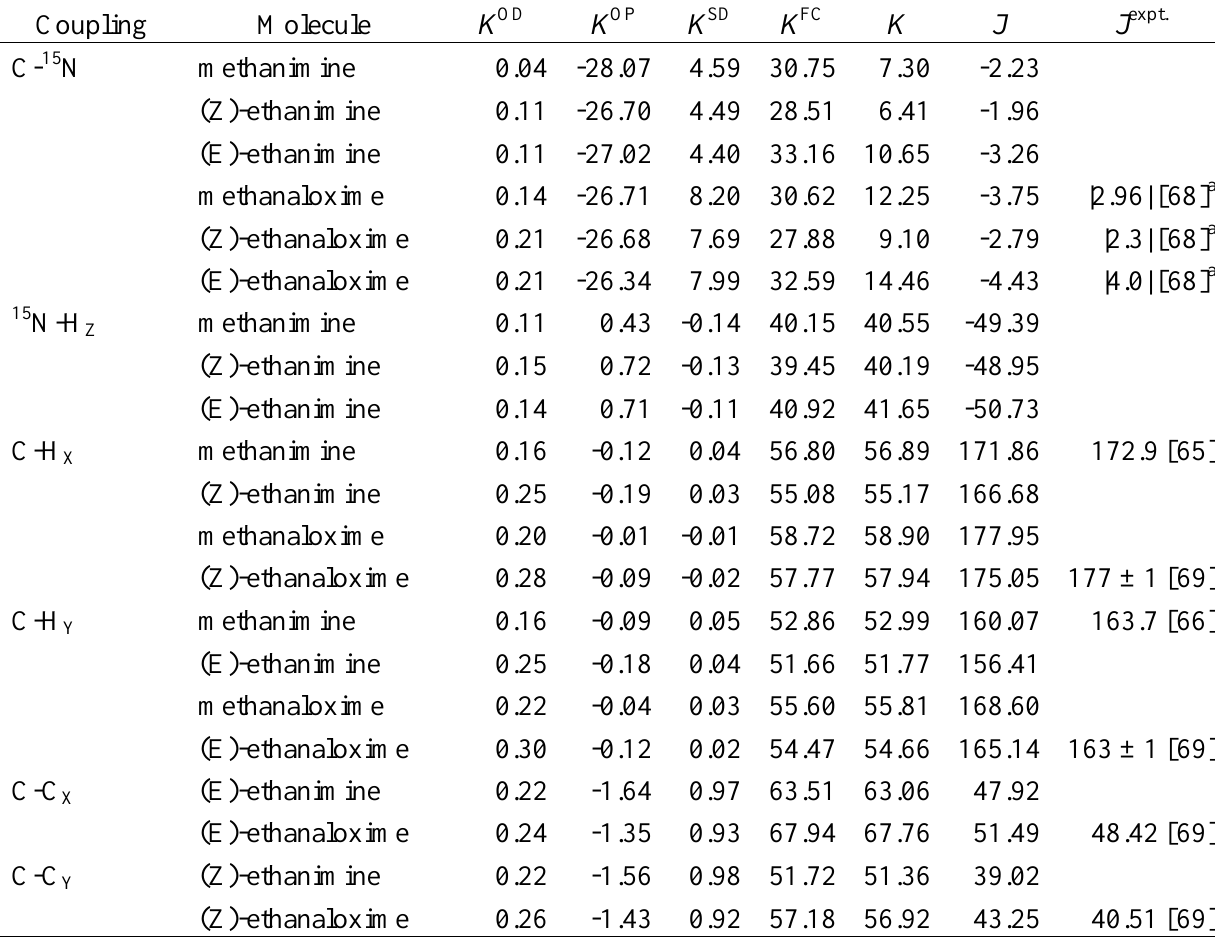
Table 1. One-bond spin-spin couplings calculated at SOPPA(CCSD) level. Coupling constants, J , in Hz and reduced coupling constants, K , in 10 19 T 2 J -1